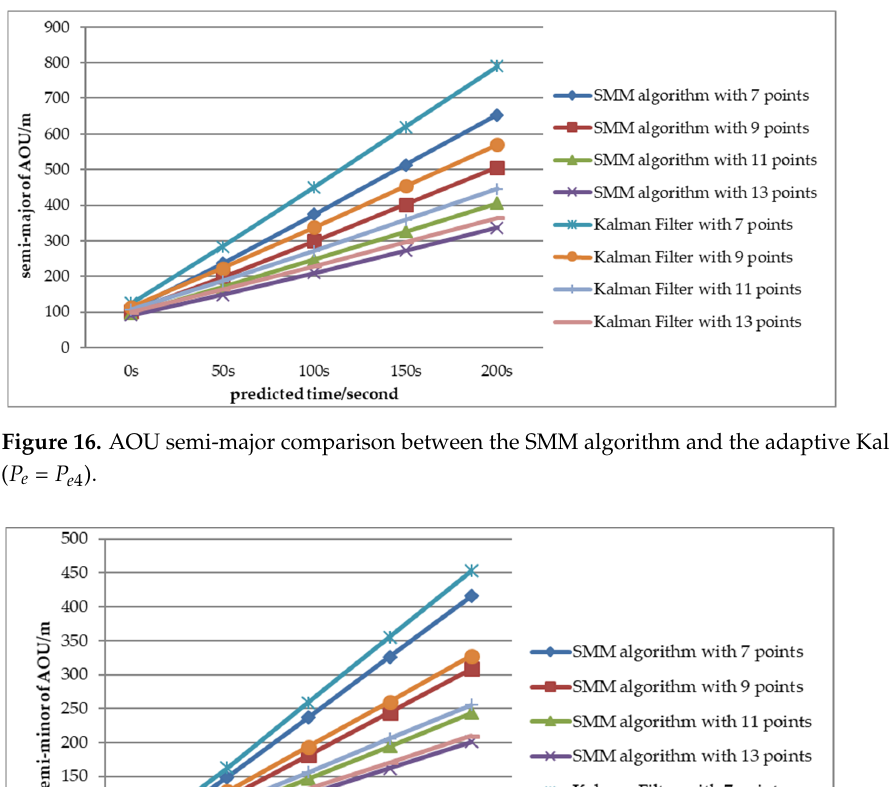
18 of 21 Figure 15. RMSE comparison of predicted position versus different detection error. ( a ) RMSE of predicted position with seven points. ( b ) RMSE of predicted position with nine points. ( c ) RMSE of predicted position with eleven points. ( d ) RMSE of predicted position with thirteen points. To evaluate the performance of AOU estimation, the AOU comparison between SMM algorithm and adaptive Kalman Filter with CV motion is shown in Figures 16–18 with Scenario 1. The semi-major and semi-minor of AOU with different number of meas- urements (7, 9, 11, and 13 points) are shown Figure 16 and Figure 17. The semi-major and semi-minor of AOU with the SMM algorithm were smaller than with the adaptive Kalman filter. With fewer measurements, the SMM algorithm was more significant than with the